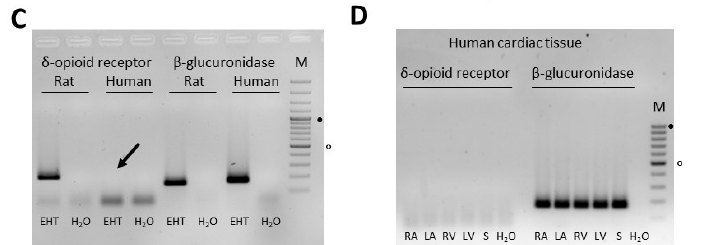
Figure 6. Hypoxia-reoxygenation injury in human EHTs. ( A ) 90 min of hypoxia (HYP) followed by reoxygenation in human EHTs (vs. time control without hypoxia, TC) (mean ± SEM). ( B ) E ff ect of preconditioning by [ d -Ala2, d -Leu5]-Enkephalin (DADLE, 100 nM, 3 × 10 min, DA) followed by 90 min hypoxia compared to the hypoxic group without preconditioning (HYP) and TC on the contractile force (shown in % of the force before hypoxia at baseline) in the early (120 min after the onset of reoxygenation) and late (day 1) reoxygenation, compared by 1-way ANOVA with Sidak‘s multiple comparisons test (HYP vs. DA, n = 4, p = 0.812 (early) and p = 0.891 (late)). Data are presented as scatterplot with mean (bars) ± SEM (whiskers). ( C , D ) PCR analyses of δ -opioid receptor expression. β -glucuronidase served as positive, water as negative control. M = marker, indicates 500 bp and 1000 bp size. ( C ) Detection of the δ -opioid receptor in rat in contrast to human EHTs. The arrow indicates the lack of a δ -opioid receptor signal in human EHTs. ( D ) PCR analysis showing absence of δ -opioid receptor mRNA in human atrial (RA = right atrium, LA = left atrium), septal (S) and ventricular (RV = right ventricle, LV = left ventricle) tissue